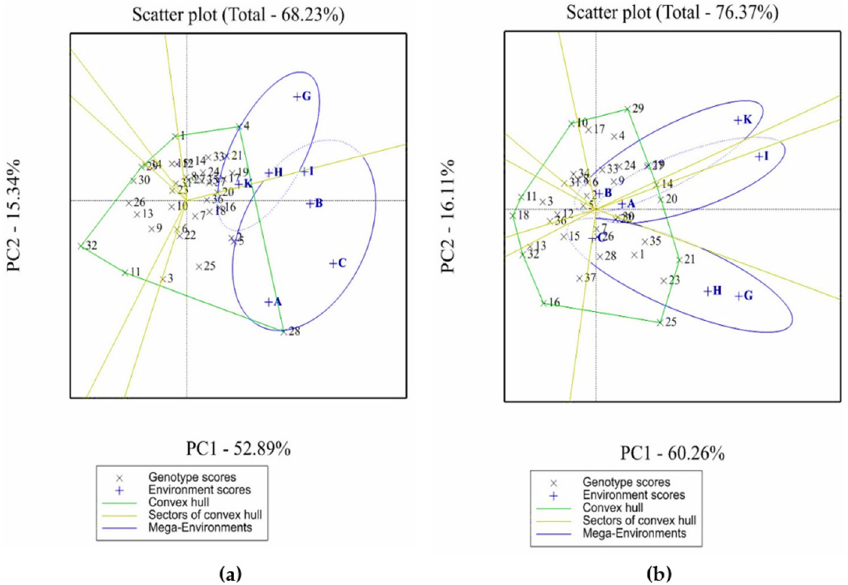
Figure 3. GGE-biplot showing the performance of each faba bean genotype in each environment and the “who-win-where” pattern of genotypes and environments for plant height ( a ) and grain yield ( b ).